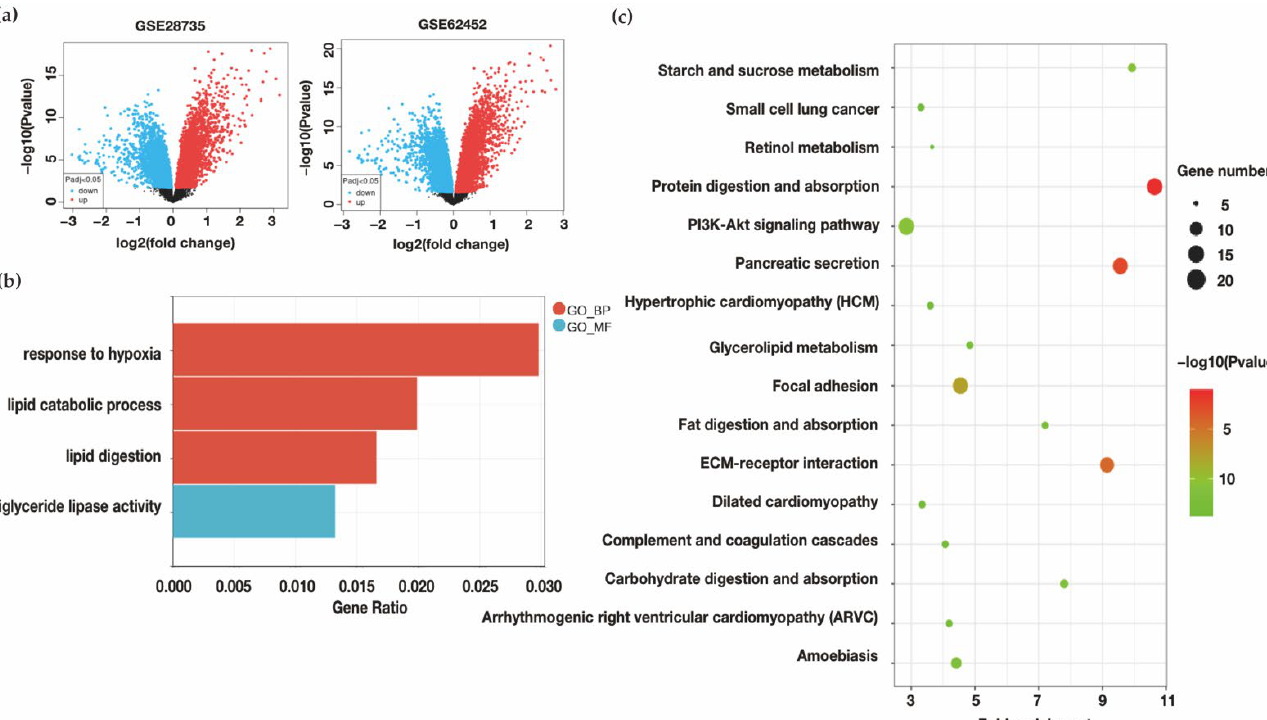
Figure 1. Identification of the occurrence of lipid metabolism disorder and oxygen change in PDAC datasets. ( a ) The volcano plot of analyses of DEGs in GSE28735 and GSE62452. ( b ) The GO molecular functions, biological processes, and cell components related to oxygen and lipid change. ( c ) The KEGG pathways enrichment in overlapping DEGs. (GO _BP: Gene ontology biological process; GO _MF: Gene ontology molecular function) (GSE28735: https://www.ncbi.nlm.nih.gov/geo/query/acc.cgi?acc=gse28735; GSE62452: https://www.ncbi.nlm.nih.gov/geo/query/acc.cgi?acc=gse62452, accessed on 15 March 2021).